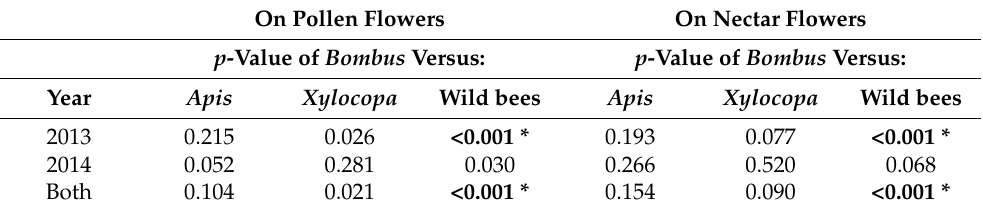
Table 8. Foraging activity of bumblebees vs. each of the other three categories as a function of ambient temperature. On Pollen Flowers On Nectar Flowers p -Value of Bombus Versus: p -Value of Bombus